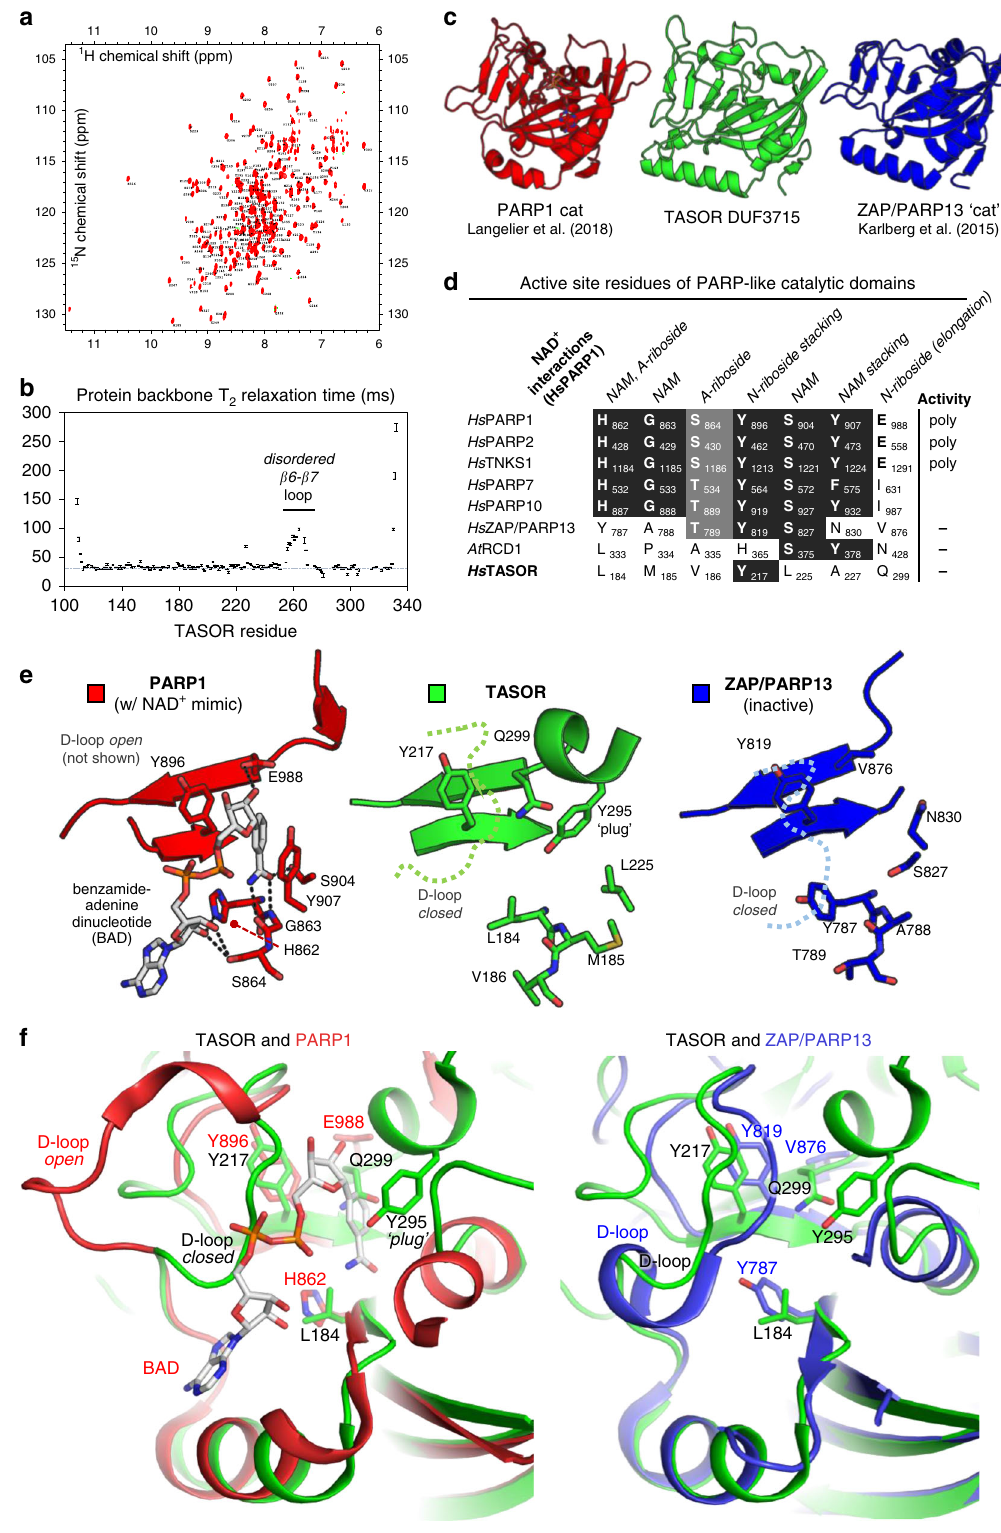
Fig. 4 TASOR DUF3715 is a PARP domain. a Assigned 1 H- 15 N BEST TROSY spectrum of 15 N-labeled TASOR(106 – 332) at 293 K. b Backbone T 2 relaxation times of TASOR(106 – 332). The disordered β 6 – β 7 loop that was removed to promote crystallization is marked. Source data are provided as a Source data fi le ( “ T2 relaxation data ” tab). c Overall structures of PARP domains of human PARP1 (red), TASOR (green), and ZAP (blue). d Alignment of PARP active sites and NAD + binding residues for a selection of PARP family members. NAM, nicotinamide; A-riboside, adenosyl-riboside; N-riboside, nicotinamide- riboside. e , f Comparison of active sites of the structures shown in ( c ), with key features